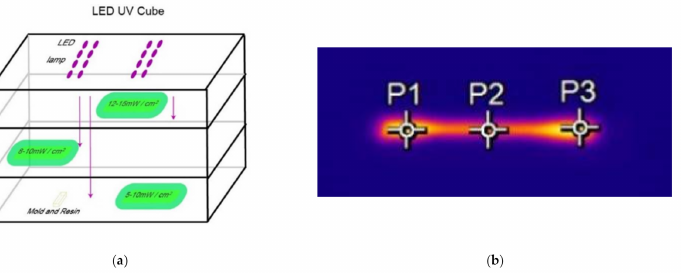
Figure 2. ( a ) Inner structure of UV oven and ( b ) sampling positions of IR camera.